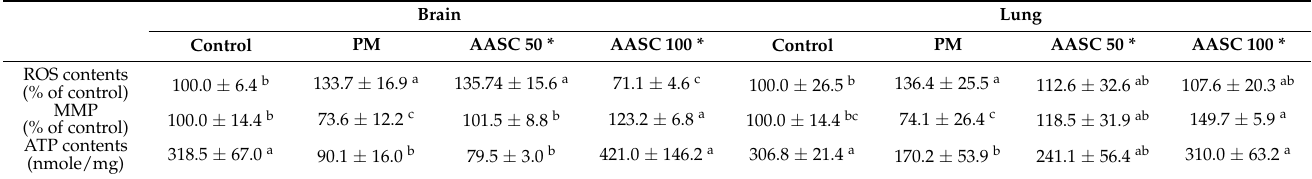
Table 5. Effect of AASC on mitochondrial function in brains of mice exposed to PM 2.5